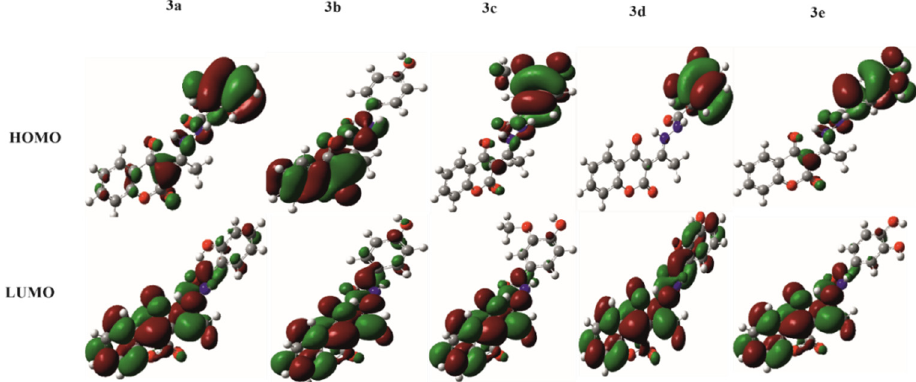
Figure 1. Frontier orbitals of the investigated compounds.